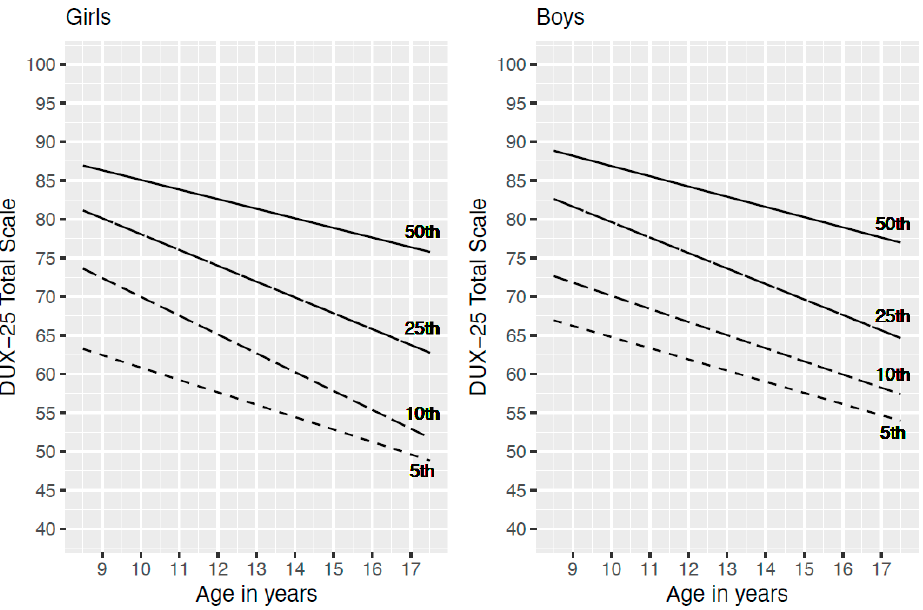
Figure 1. 5th, 10th, 25th and 50th Percentile for DUX-25 Total Scale by Age. Table 5. Descriptives, DUX-25 Scale Means by Family Member and Age Group.